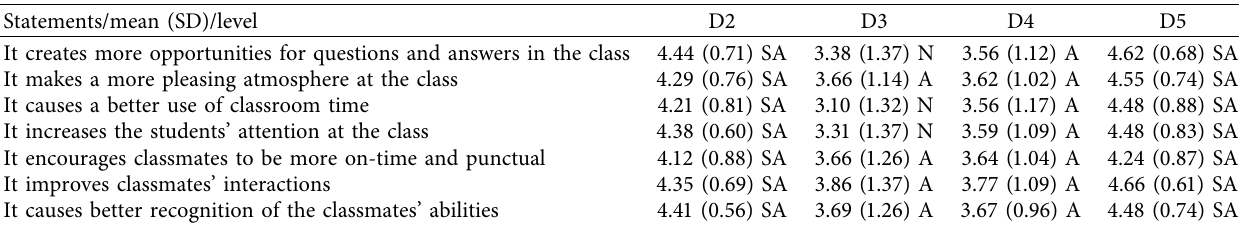
Table 3: Mean, standard deviation, and level of statements of the third parameter (class environment), according to the Likert scoring method where SA is referred to strong agree, A is referred to agree, and N is referred to neutral.